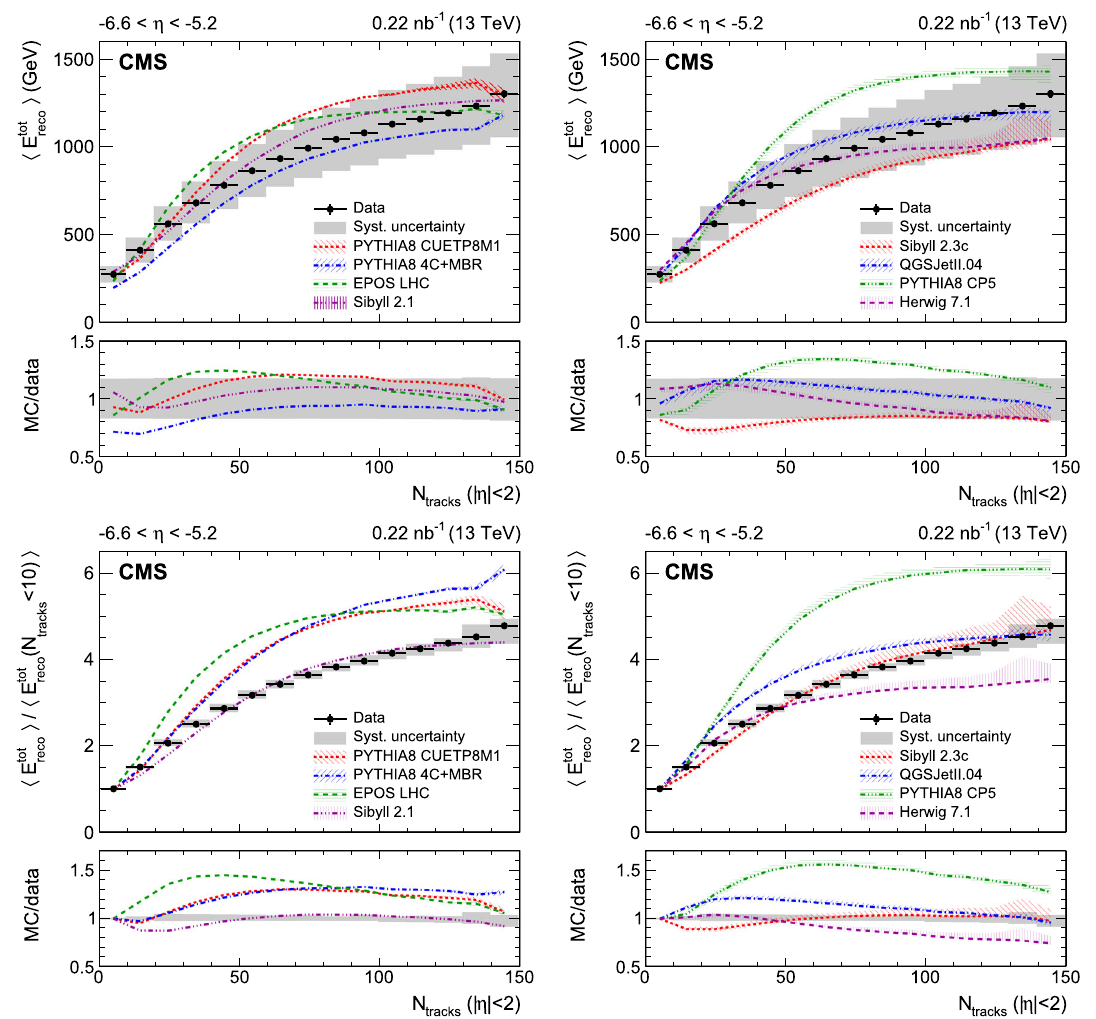
Fig. 1 Top panel: Average total energy reconstructed in the CASTOR calorimeter as a function of the number of reconstructed tracks for | η | < 2. Bottom panel: Average total energy reconstructed in the CAS- TOR calorimeter normalised to that in the first bin ( N ch < 10) as a functionofthenumberofreconstructedtracksfor | η | < 2.Inallfigures,